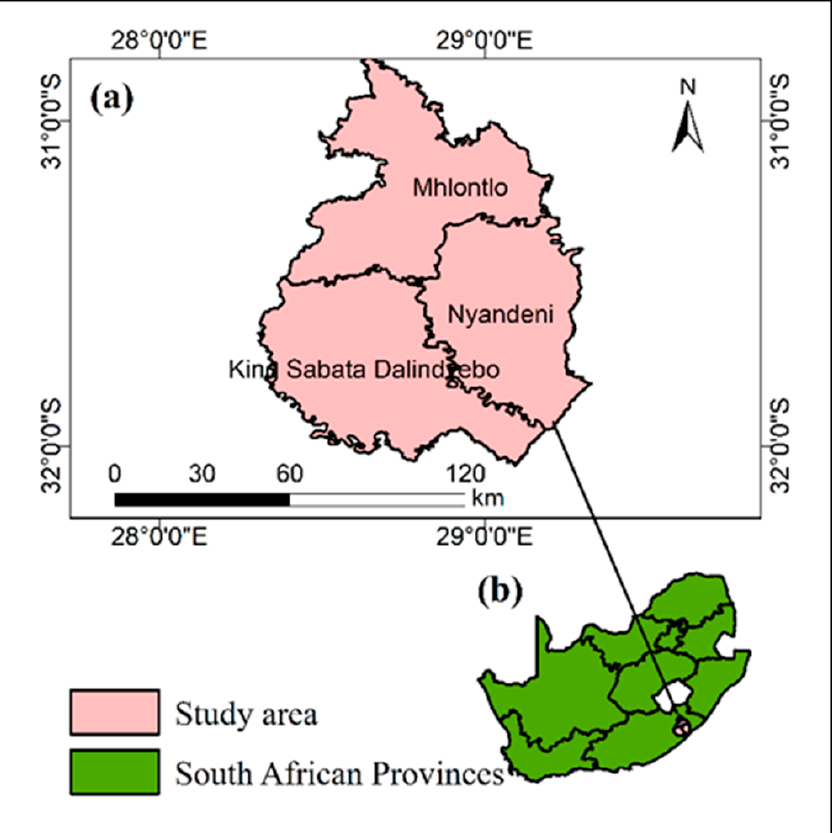
Figure 1. Study area ( a ) within South Africa ( b ).